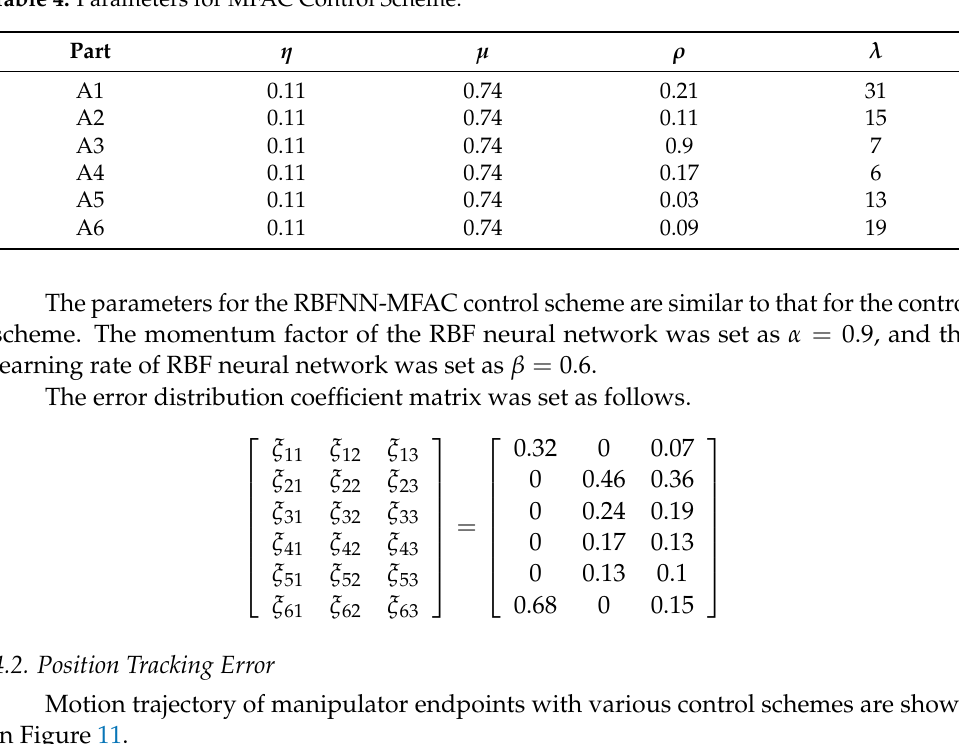
Table 4. Parameters for MFAC Control Scheme.